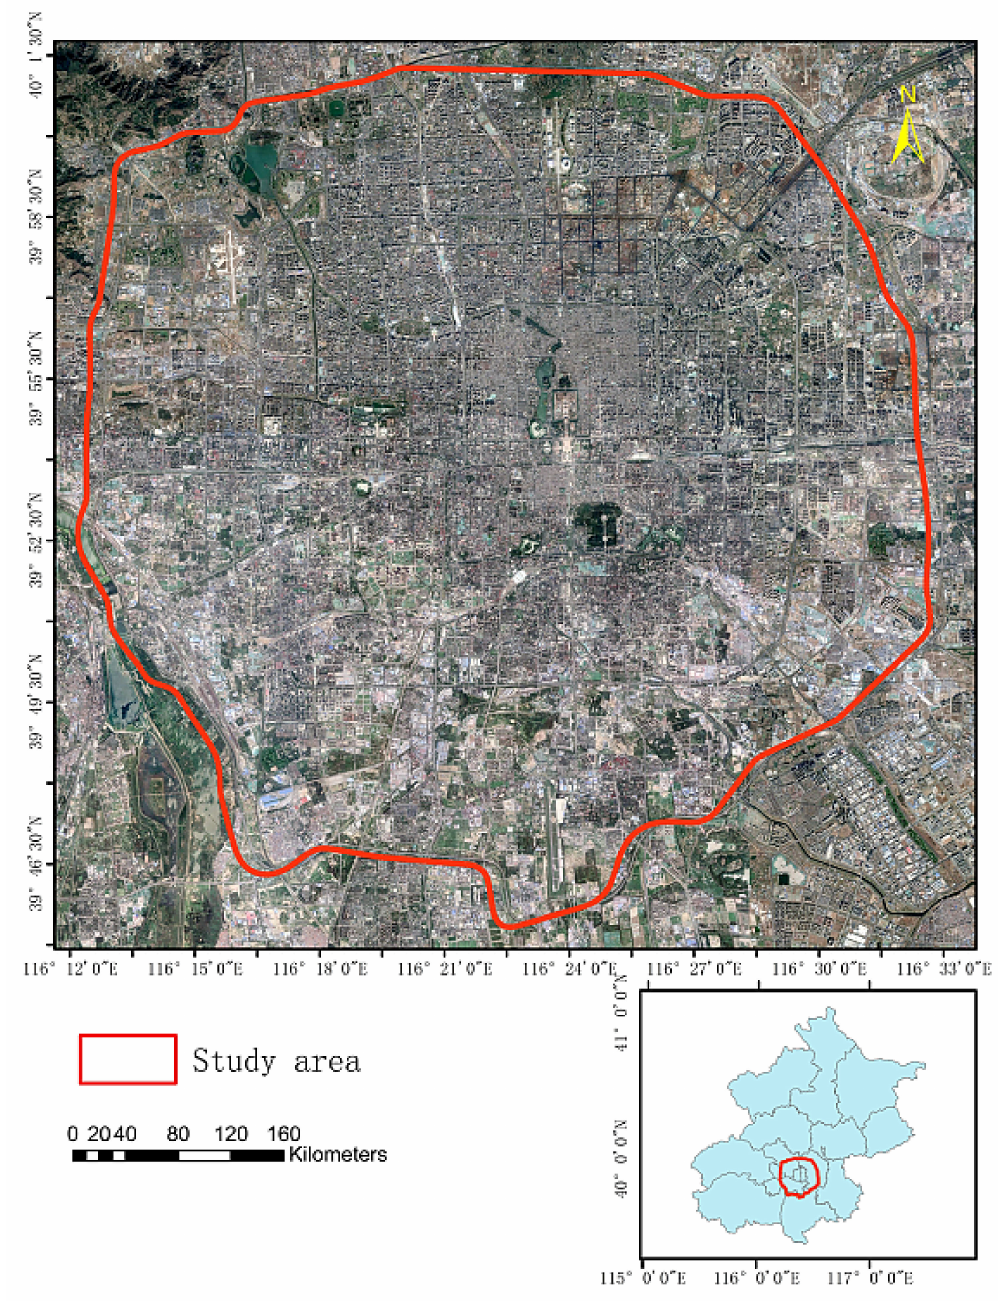
Figure 1. The study area and its location in Beijing. The image data are L14-level data obtained from Google